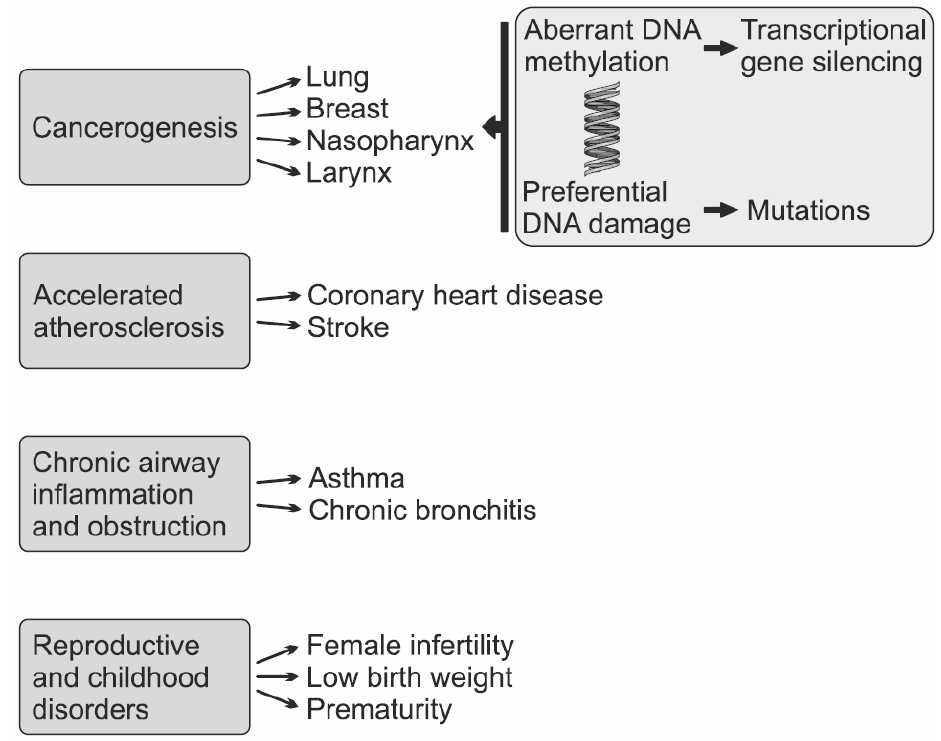
Figure 2. Proven health effects of secondhand smoke and the mechanism of its action on genes.